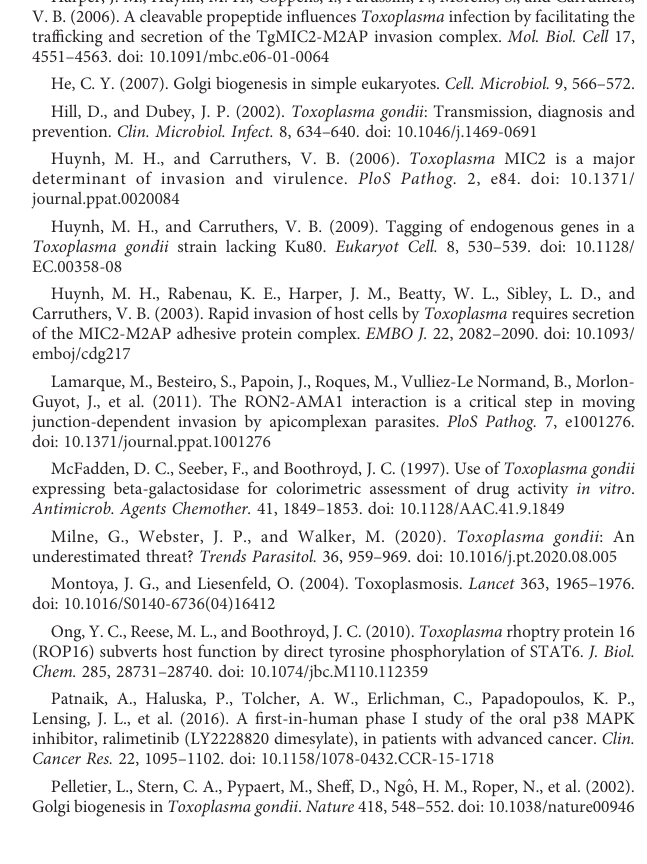
SUPPLEMENTARY FIGURE 1 Acoustic dispensing principles and apparatus. SUPPLEMENTARY FIGURE 2 Pre-screening of effective pyrimethamine and DMSO concentrations allowing the image-based drug identi fi cation. (A) Impact of different DMSO concentrations on the uninfected HFF cells. (B) : Two independent experiments using different pyrimethamine concentrations tested on 7,000